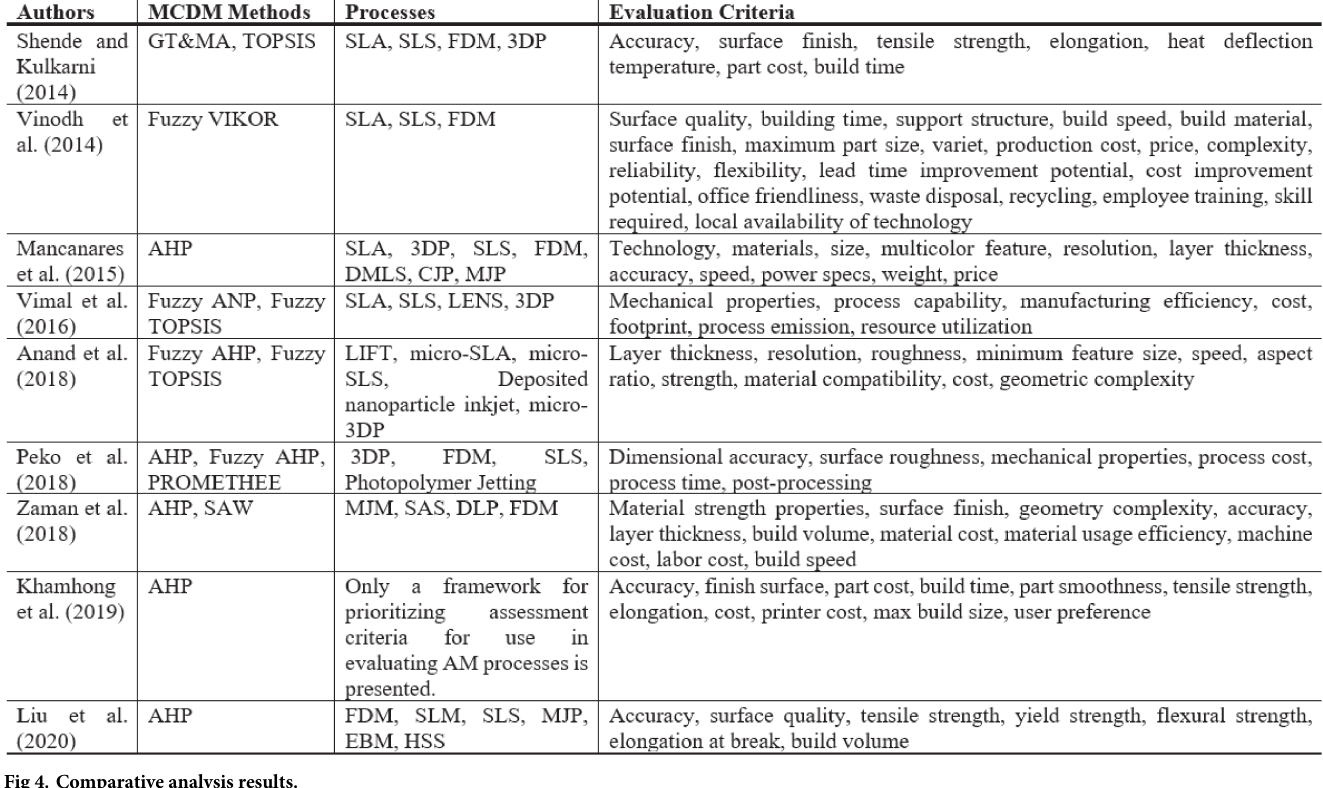
Fig 4. Comparative analysis results.